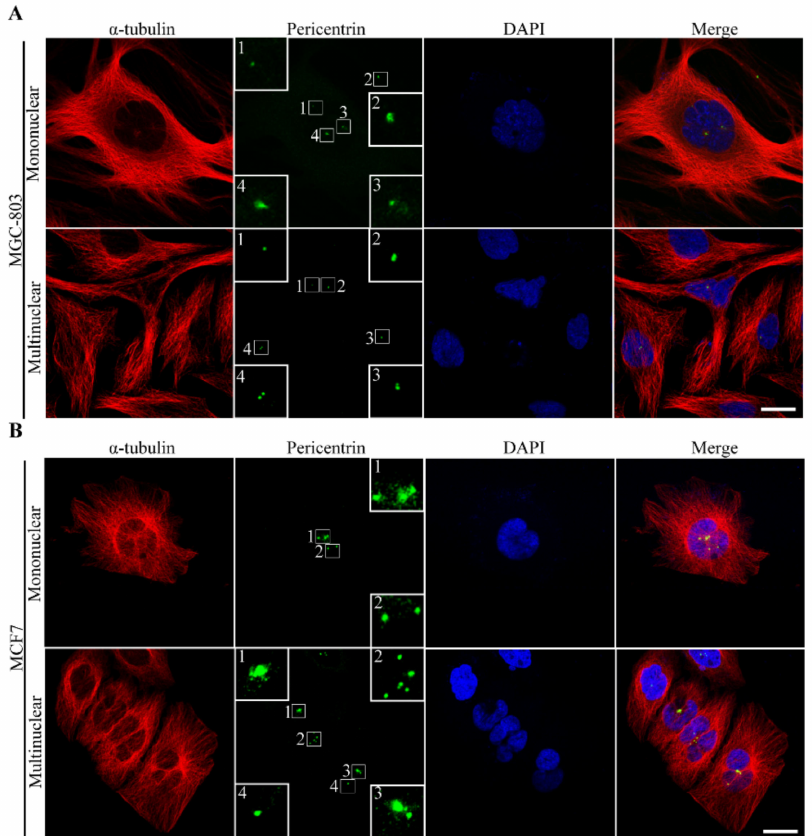
Figure 6. Multiple centrosomes in both mononuclear and multinuclear human cancer cells caused by heat stress. Immunofluorescence images stained with α -tubulin (red), pericentrin (green) antibodies and DNA (blue) of ( A ) MGC-803 cells and ( B ) MCF-7 cells, scale bar: 12 µ m. Multiple foci of PCM were found in both mononuclear and multinuclear cells, implying supernumerary centrosomes induced by heat